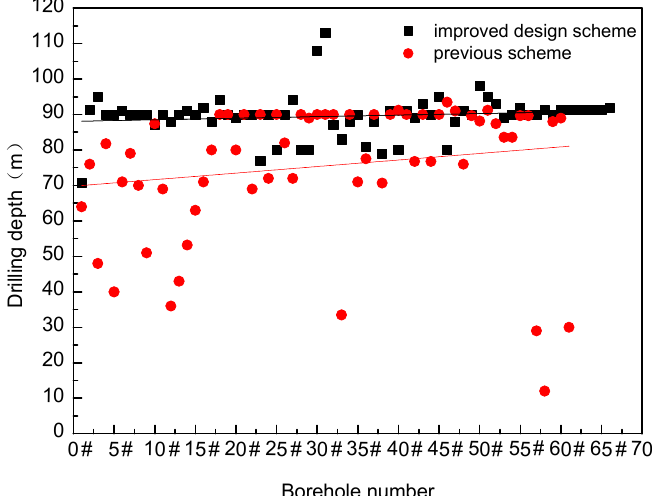
Figure 12. Comparison of the data from the engineering application.